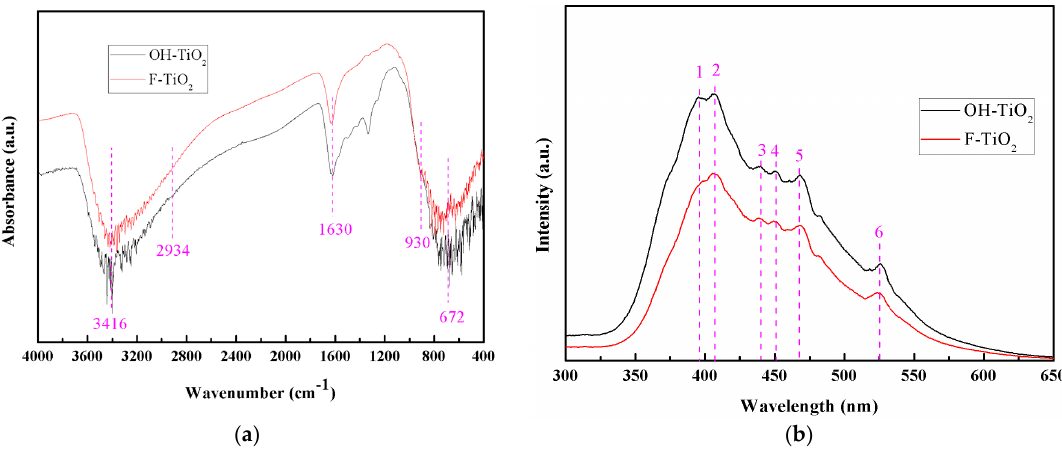
Figure 5. ( a ) Fourier transform infrared (FT ‐ IR) spectra and ( b ) Photoluminescence (PL) emission spectra of as ‐ prepared F ‐ TiO 2 and OH ‐ TiO 2 samples.